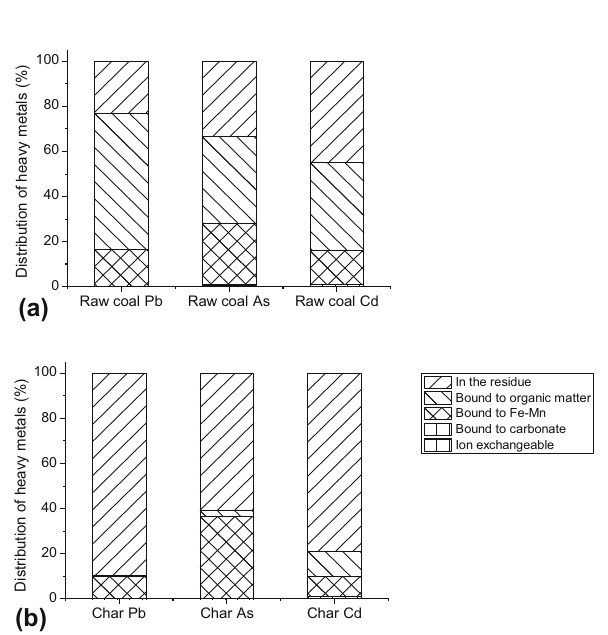
Fig. 4 The distribution of heavy metals in raw coal and char (800 (cid:3)